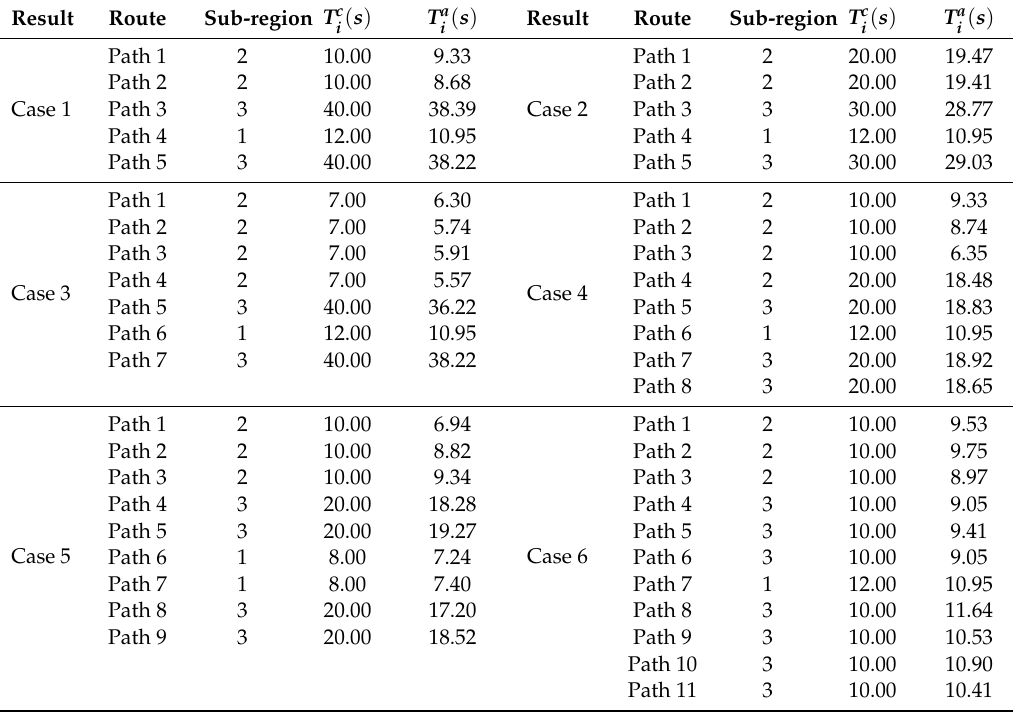
Table 6. Coverage periods and actual coverage time for each route.